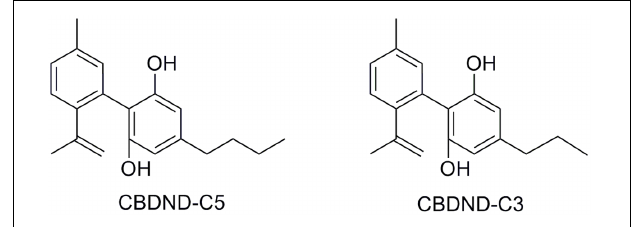
FIGURE 3 | Aromatic analogs of CBD.